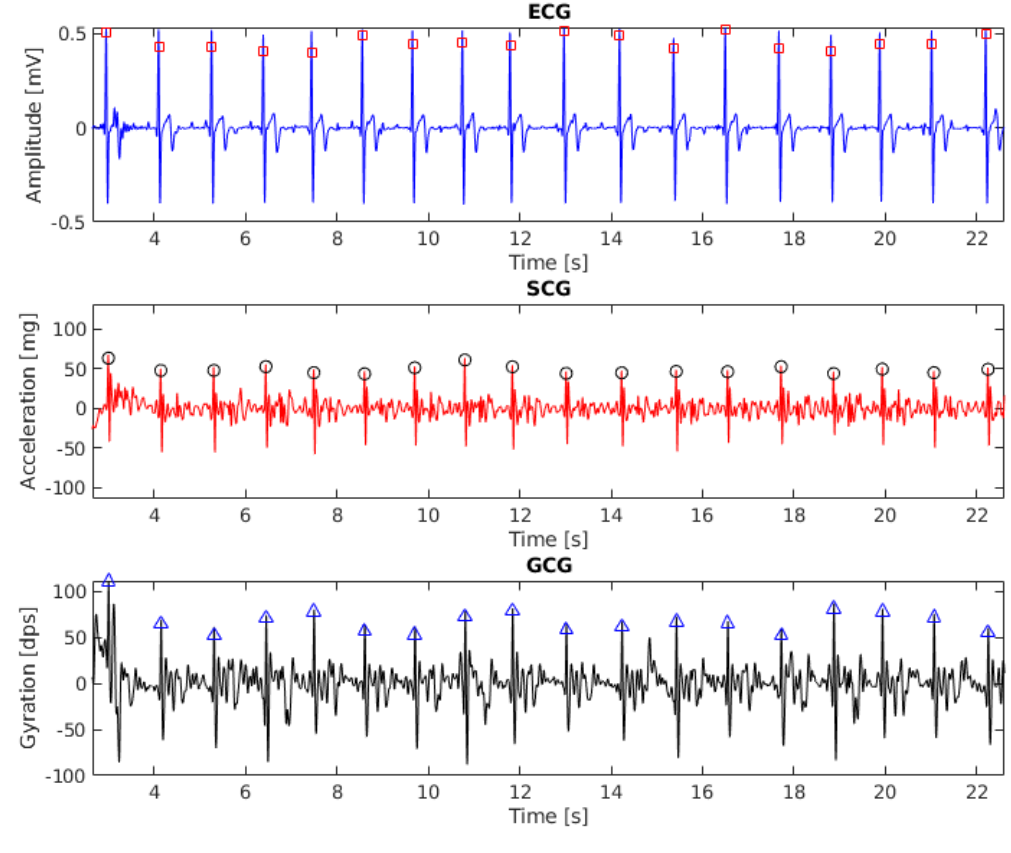
Figure 1. Electrocardiogram (ECG), seismocardiogram (SCG) and gyrocardiogram (GCG) signals with annotated heartbeats (subject 6, 20 s fragment). Detected heartbeats are shown as squares (for ECG), circles (for SCG) and triangles (for